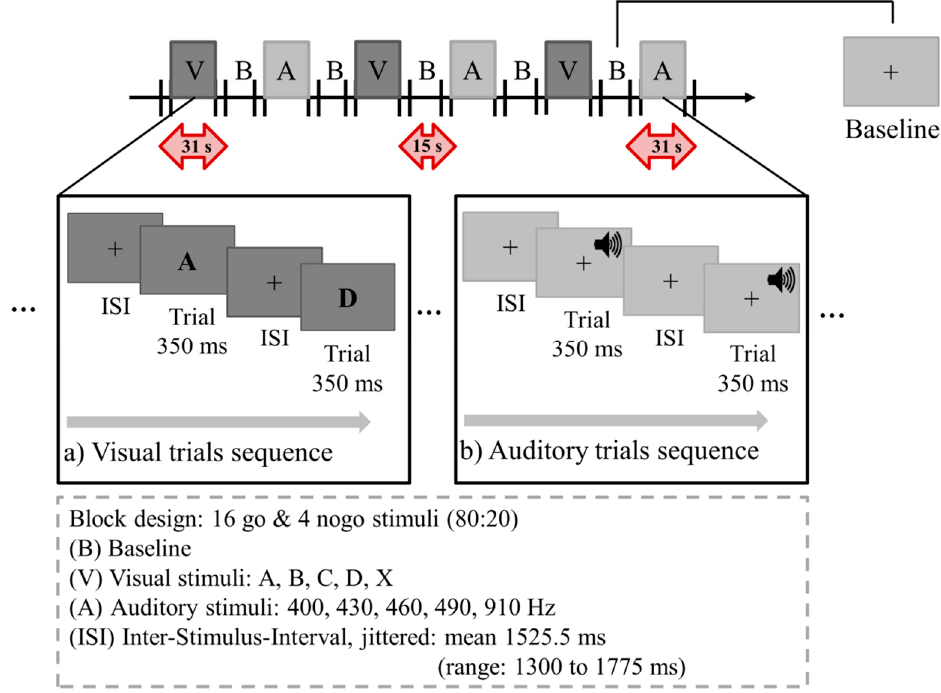
Figure 1. Experimental design and trial structure. Abbreviations: B, Baseline; V, Visual; A, Auditory; ISI, Inter-stimulus-interval.